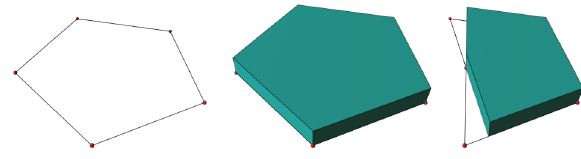
Figure 5: From convex polygon to convex polyhedron: The top and bottom planes are constructed from a given extrusion depth, and each polygon segment yields one side plane. In case the poly- gon is nonconvex, the solid is automatically